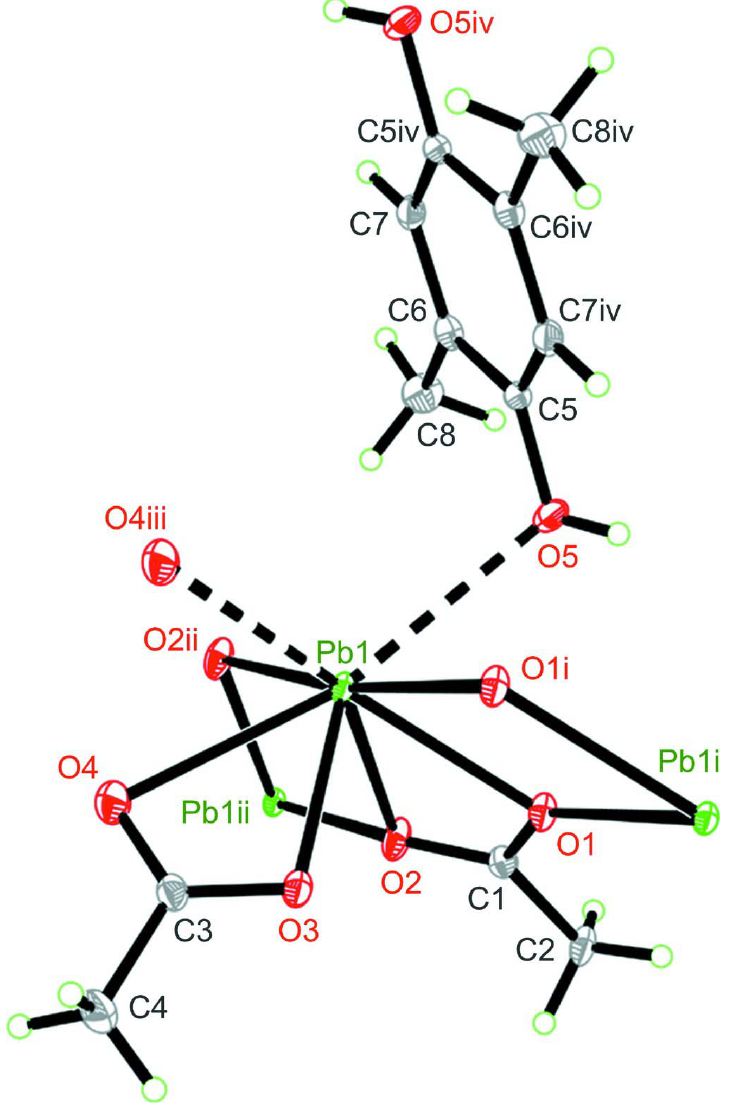
H O Pb : C 24.36, H 2.81%; found: C 16 22 10 2 ), 3 (H) = 1.5 U (C, O) and U (H) = iso eq iso